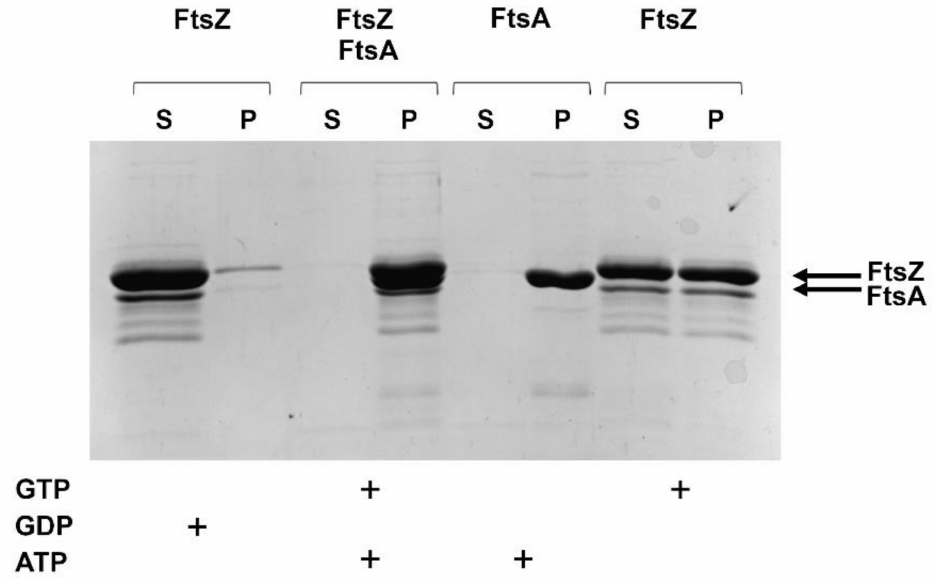
Figure 7. In vitro reconstitution of the FtsZ / FtsA interaction. FtsZ was induced to polymerize in the presence or absence of FtsA and GTP or GDP. The co-sedimentation was carried out in the presence of vesicles. The polymeric FtsZ and FtsA were collected by sedimentation and the amount of proteins in the pellet (P) was estimated by coomassie-blue staining of SDS-PAGE. S,